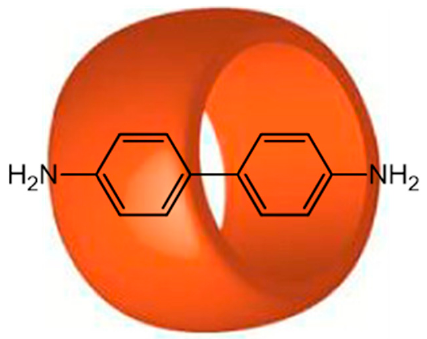
Figure 5. Model of interaction between Q[7] and AN.